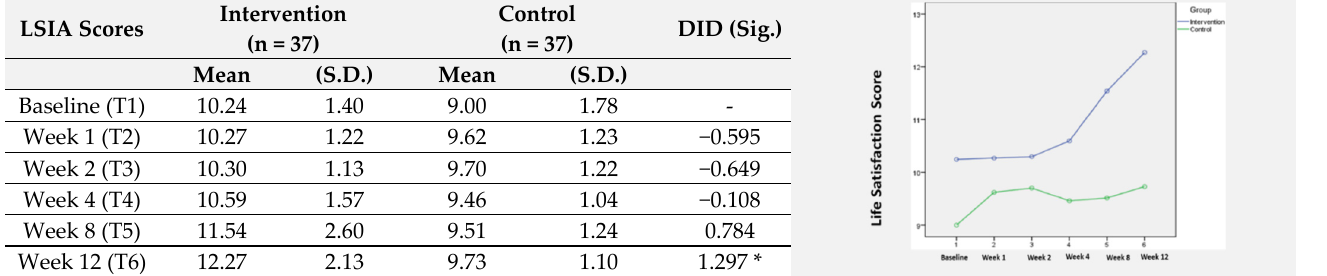
Table 4. Comparison of mean QoL scores between groups over